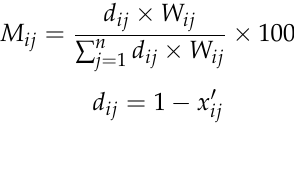
Table 3. The coupling mechanism of the RES index and REP index.